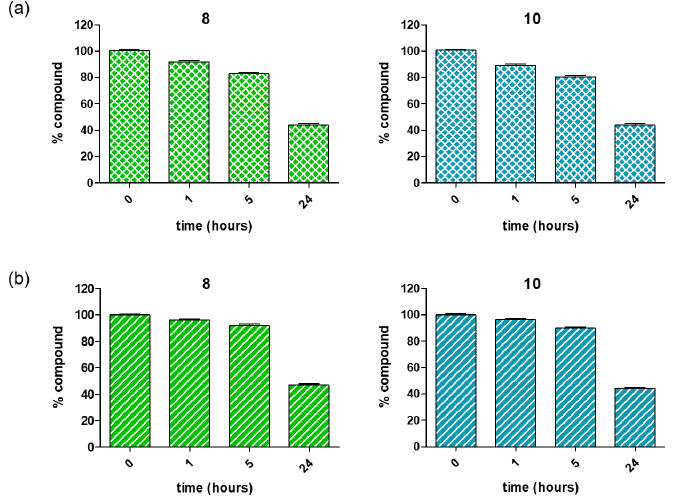
Figure 5. Stability of compounds 8 and 10 over 24 h: ( a ) in RPMI medium, ( b ) in human serum.